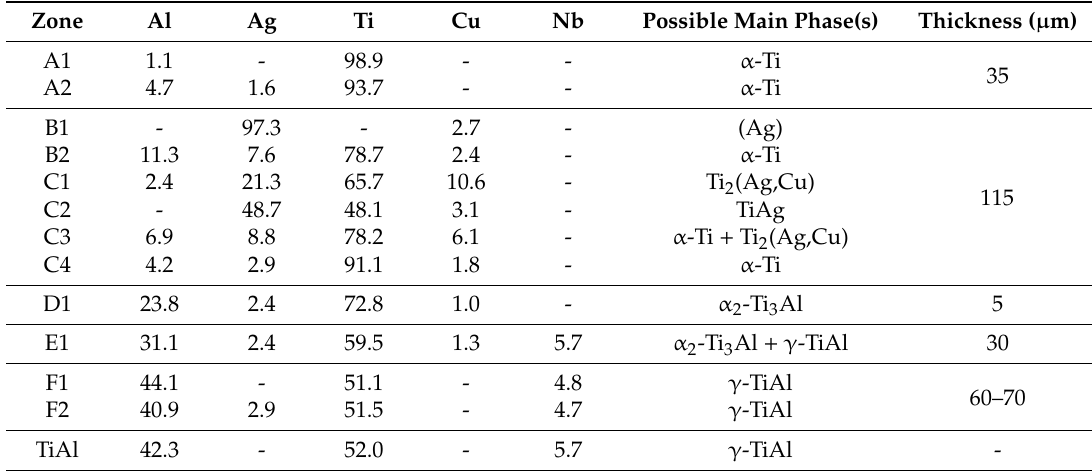
Table 1. EDS chemical composition (in %) of the zones of interest illustrated in Figure